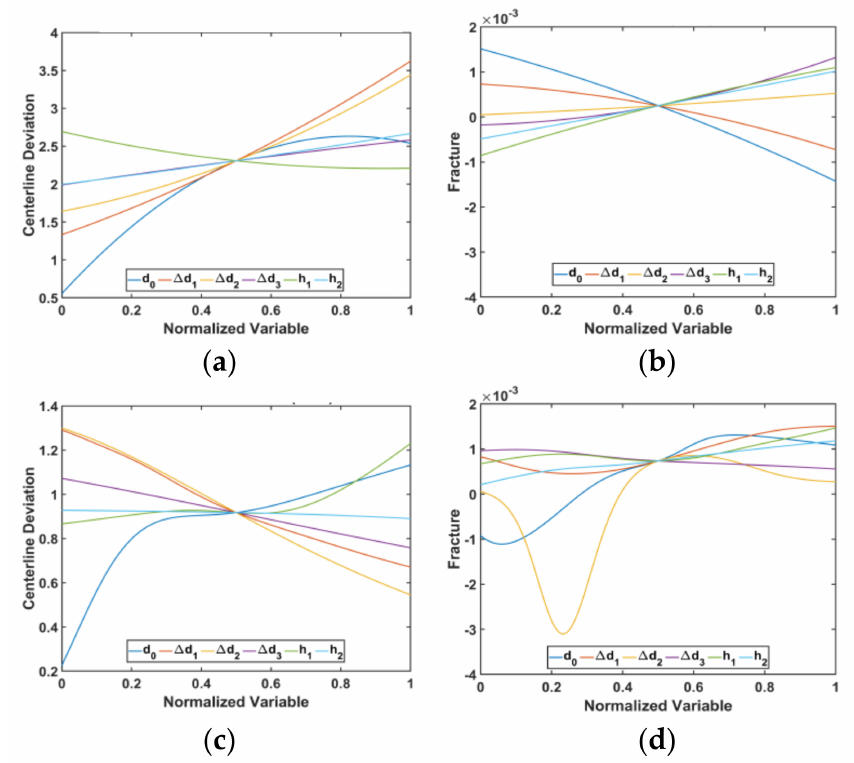
Figure 17. Variation of objective functions in each variable when other variables are fixed. RSM: ( a ) centerline deviation, ( b ) fracture; ANN: ( c ) centerline deviation, ( d )